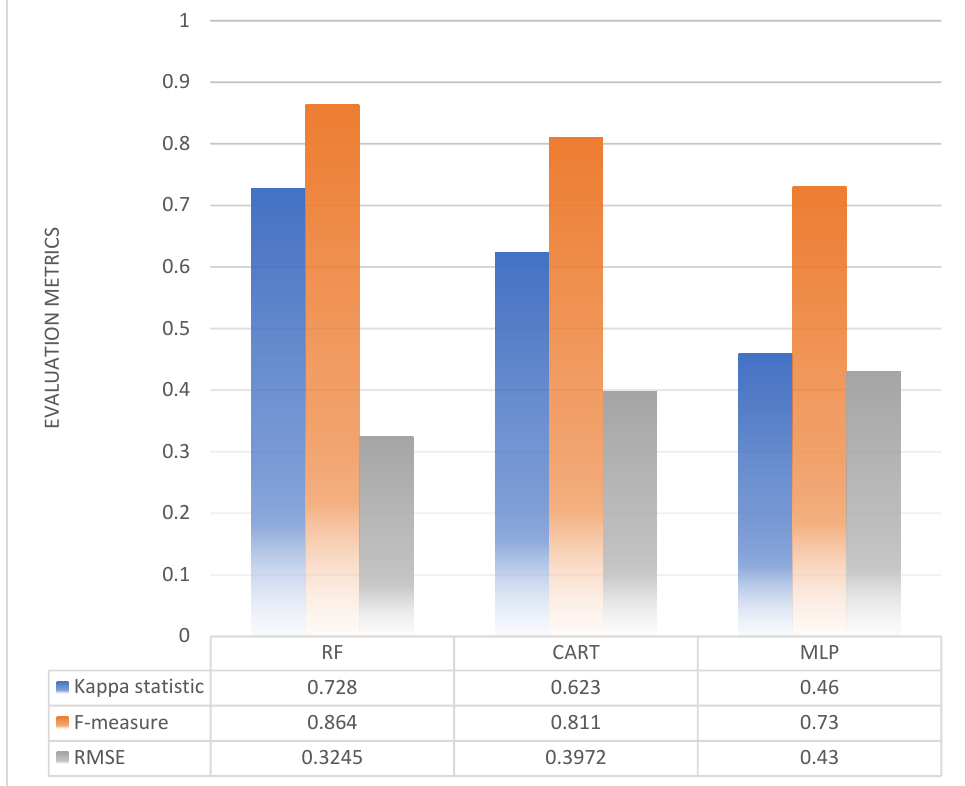
Figure 7. Kappa, F-measure, and RMES Results.